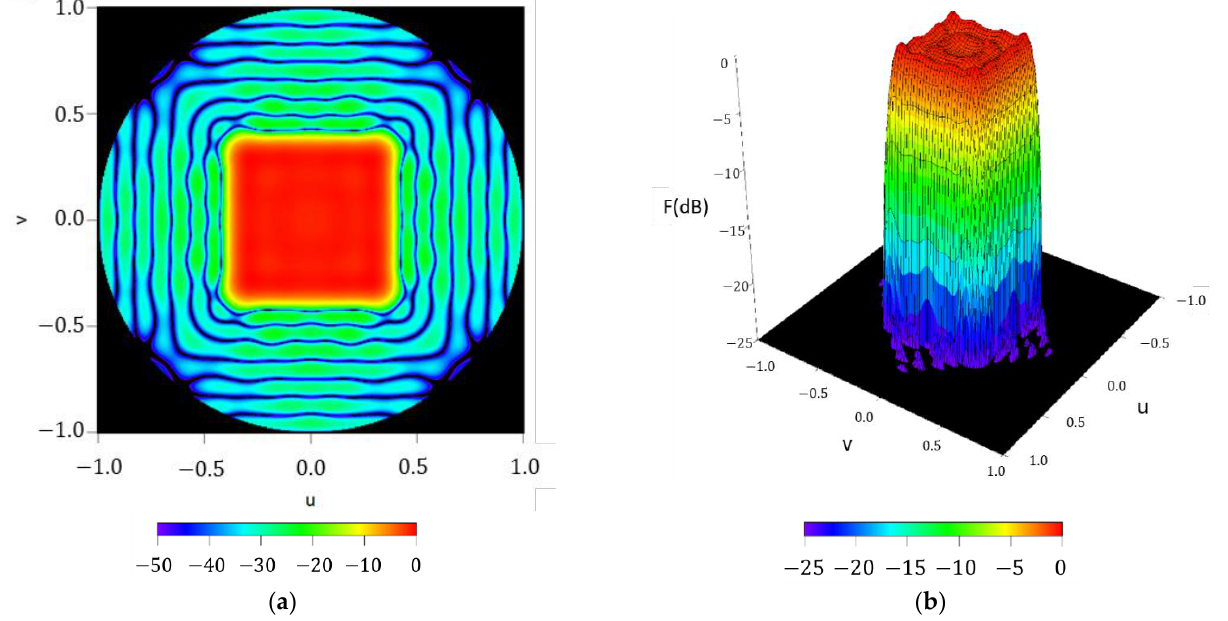
Figure 6. Reconstructed pattern of the required footprint for the case of a squared boundary of 40 ◦ × 40 ◦ by means of a discretized array antenna: ( a ) interpolated image with a threshold level set at − 50 dB; ( b ) surface plot with a threshold level set at − 25